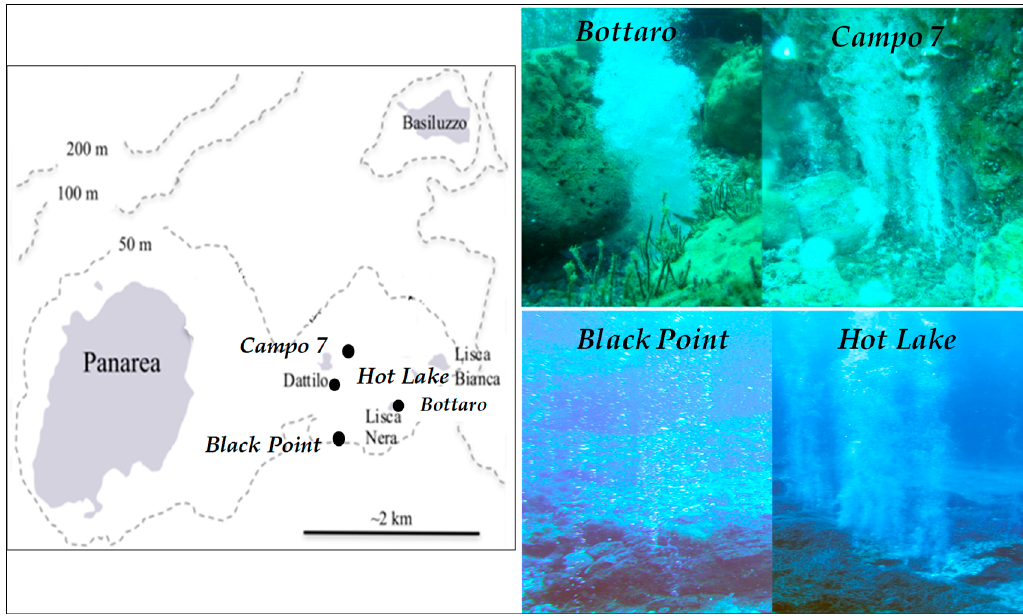
Figure 3. Map of Panarea Island and surrounding islets. Sampling sites’ location (closed circles) and vents emissions at Bottaro, Campo 7, Black Point, and Hot Lake.